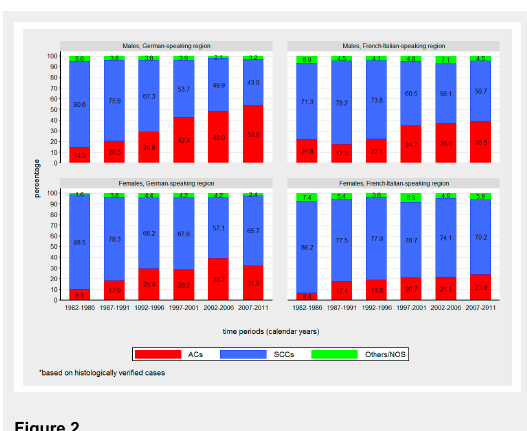
Time trends in proportions of oesophageal cancer cases by sex, histologic subtype and language region from 1982 to 2011. ACC = adenocarcinoma; SCC = squamous cell carcinoma, Others/ NOS = other histologic subtype / not otherwise